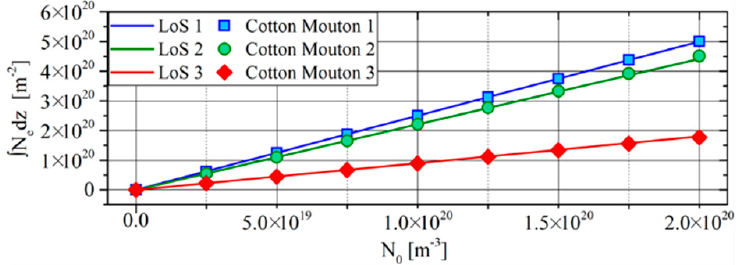
Figure 6. Validation of the Cotton–Mouton phase shift by comparing the electron density line integral with the CM electron density.